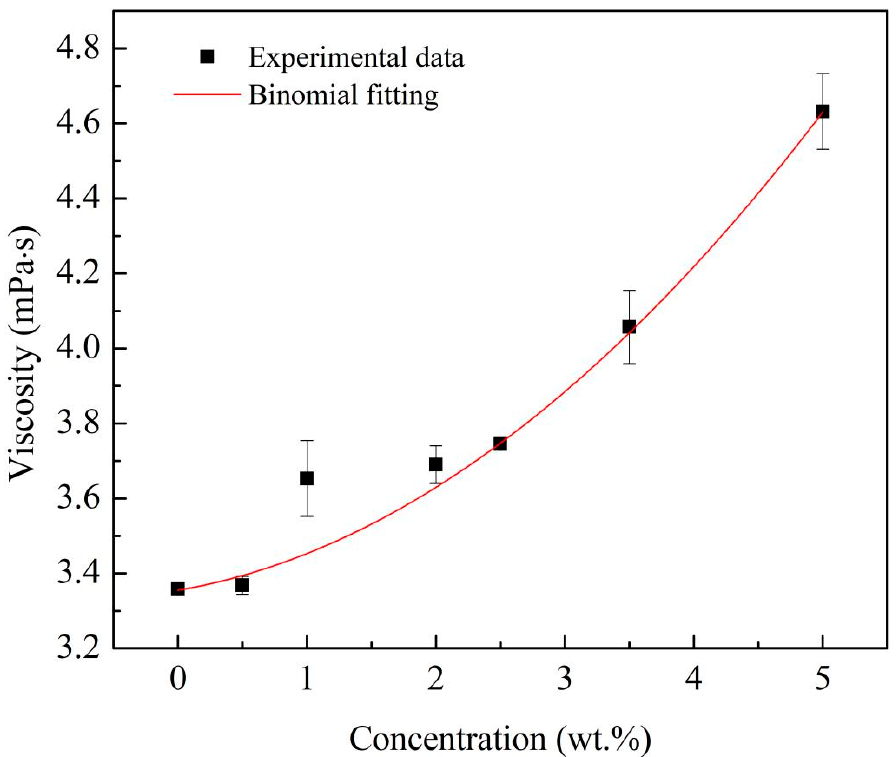
Figure 6. Viscosity of Al/JP-10/oleic acid nanofluid fuels at different Al concentrations.